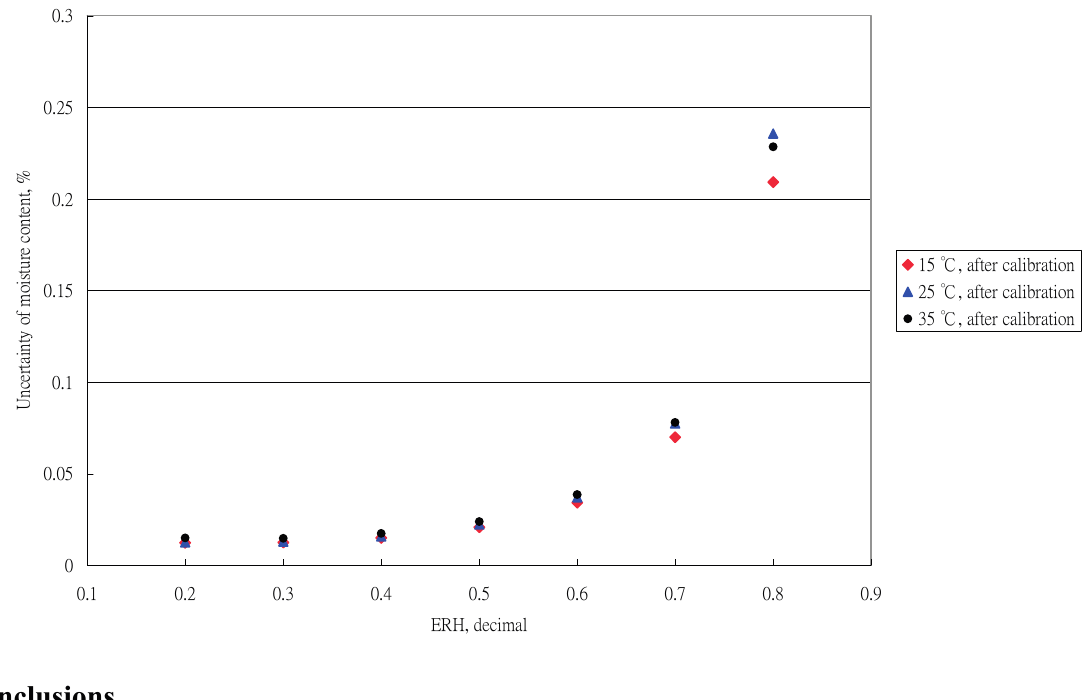
Figure 8. Effect of the temperature environment on moisture